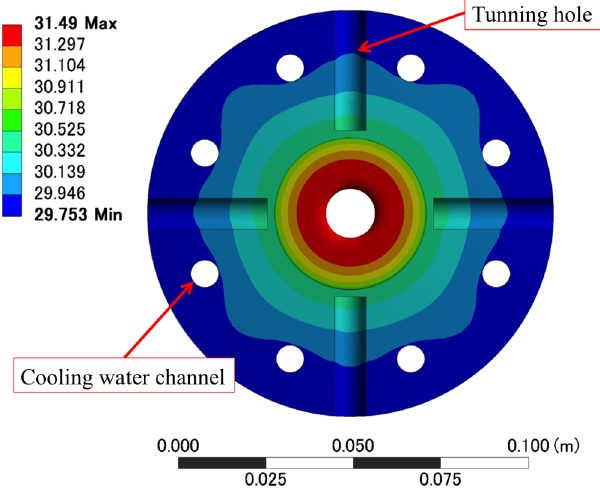
FIG. 3. Estimated temperature distribution of one accelerating cell with a cooling-water temperature of 27 . 6 °C at 120 pps operation. The rf power to be inputted to the accelerating structure is 80